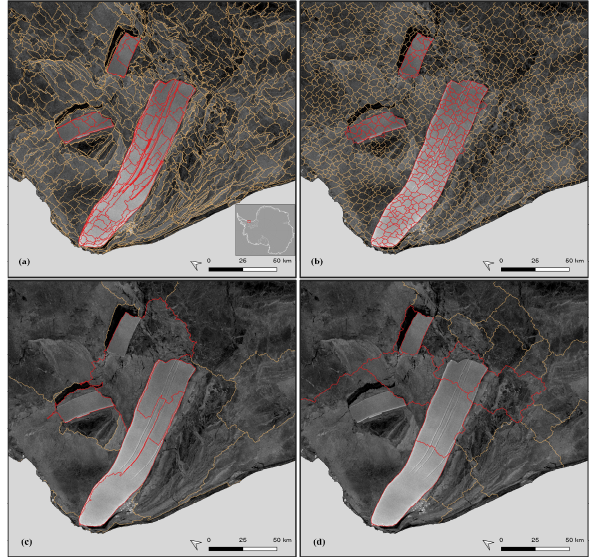
Figure 3. Examples of segmentation results with the compactness parameter set to 0.5 in all experiments: (a) a scale parameter of 100 with a fixed threshold of 0.1 for shape parameter, (b) a scale of 100 with shape parameter for 0.5, (c) a scale parameter of 800 with the shape parameter for 0.1, and (d) a scale parameter of 800 with a shape parameter of 0.5. The brown lines demarcate the image object boundaries of the background and the red lines contain iceberg boundaries. The location of the study area is shown in the inset of Figure